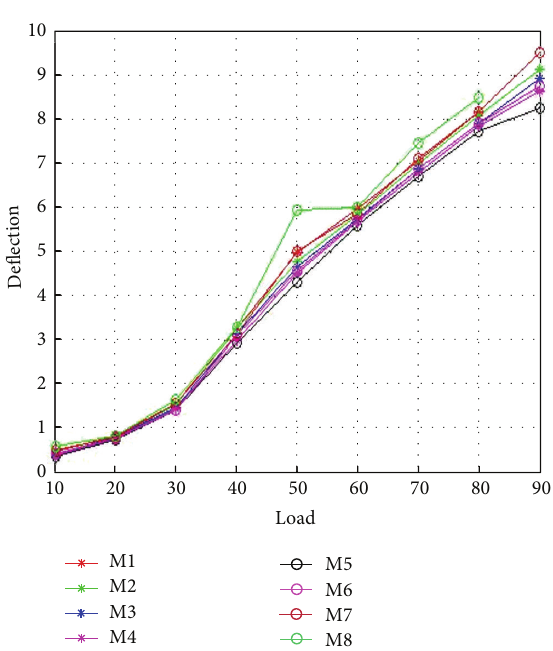
Figure 5: Load versus